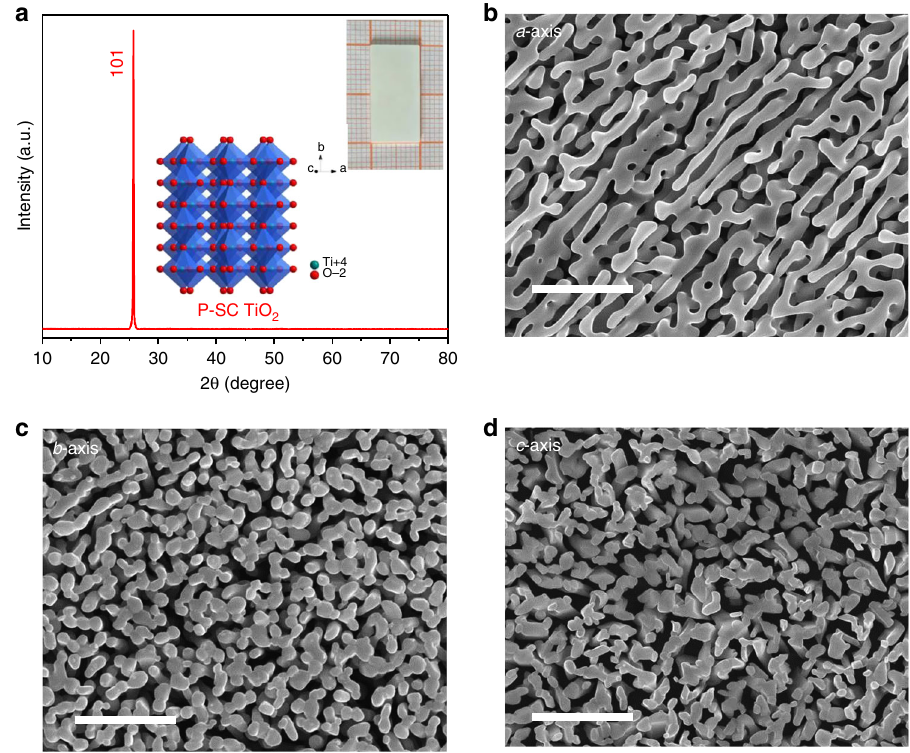
Fig. 1 XRD and SEM characterization of porous single-crystalline (P-SC) anatase TiO 2 crystals. a the XRD of P-SC TiO 2 crystals grown along the a -axis, b - axis and c -axis of KTiOPO 4 (KTP) substrates. The inset is the crystal structure of anatase TiO 2 view along 101 axis. b the SEM of P-SC Ti 38 O 75 crystals grown along the a -axis of KTP. c the SEM of P-SC Ti 38 O 75 crystals grown along the b -axis of KTP. d the SEM of P-SC Ti 38 O 75 crystals grown along the c - axis of KTP. The KTP substrates with dimensions of 20 mm × 10 mm × 0.5 mm are used for the growth of P-SC Ti 38 O 75 crystals in Ar at 600 – 800 °C. The scale bar is 1 μ m in b , c and